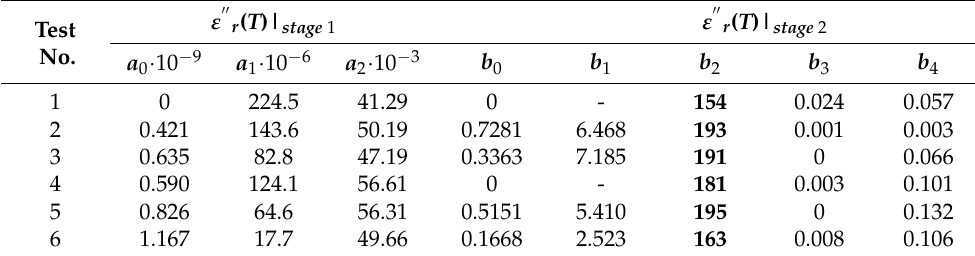
Table 3. Fitting curve parameters for the loss factor model described by Equation (5).